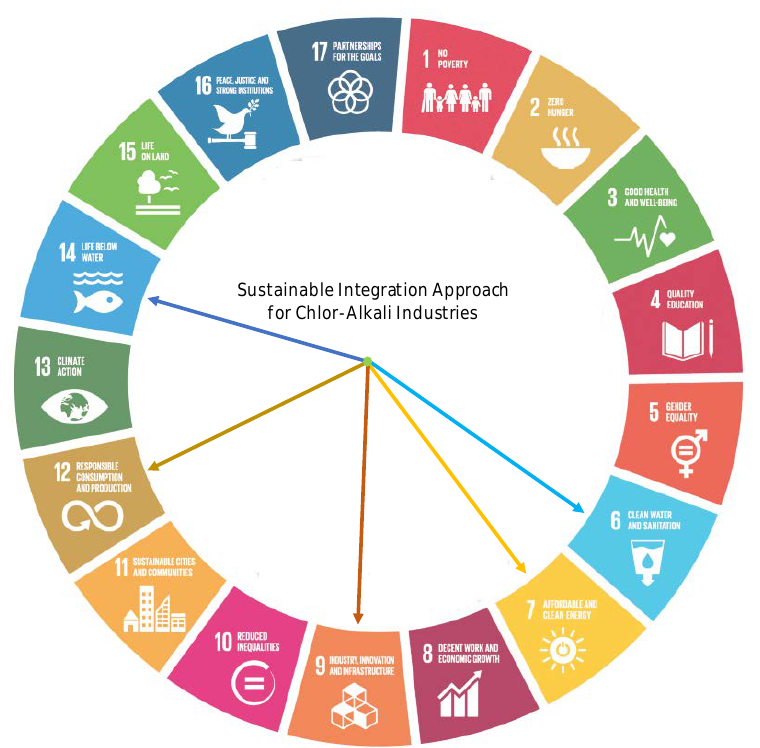
Figure 8. Specific goal addressing of SDGs by sustainable chlor-alkali industry integration [41].